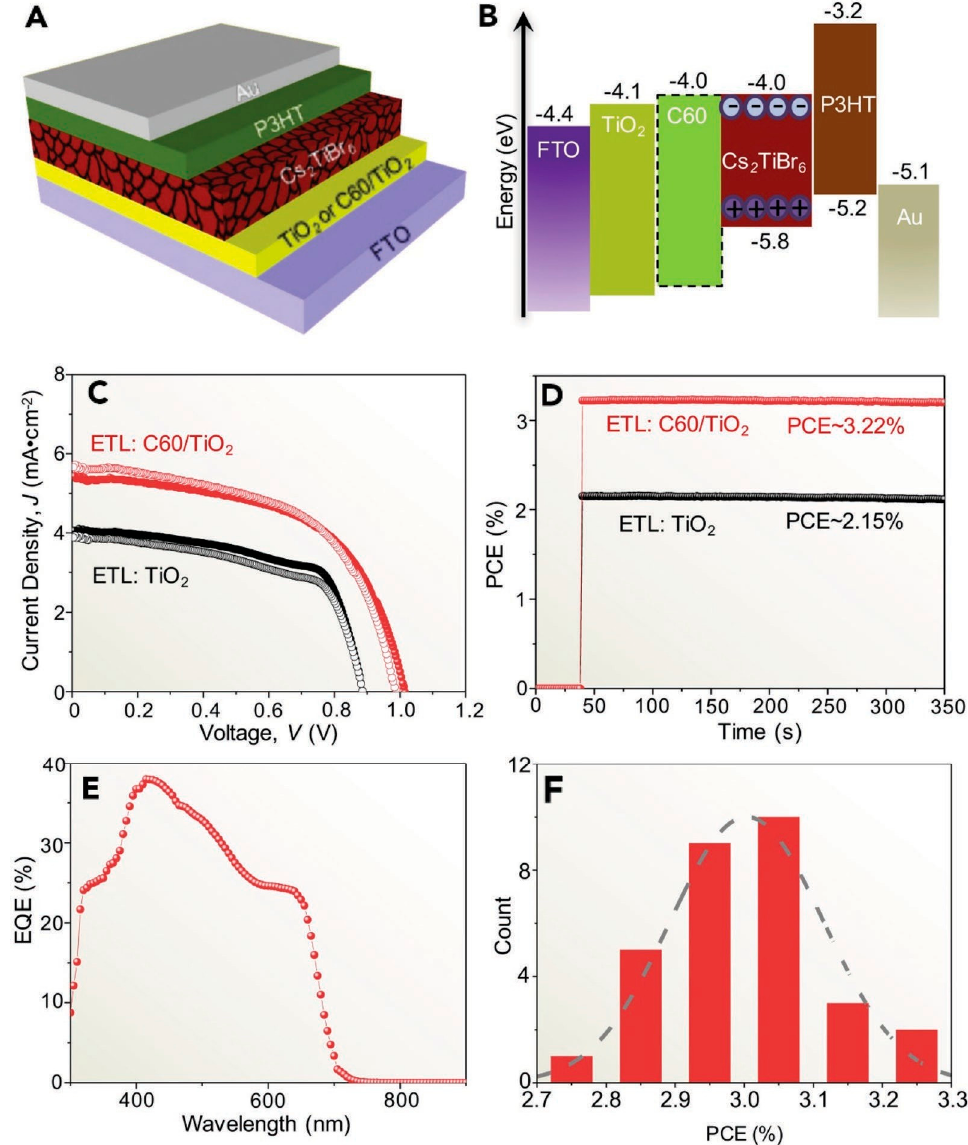
Figure 10. ( A ) Planar architecture of Cs 2 TiBr 6 perovskite thin film; ( B ) Energy level diagram; ( C ) J ‐ V characteristics during forward (hollow circles) and reverse (solid circles) scans with and without C60 interfacial layer; ( D ) Stabilized PCE output with and without C60 interfacial layer; ( E ) EQE spectrum with C60 interfacial layer; and ( F ) Efficiency histogram with C60 interfacial layer. Adapted with permission from [93].